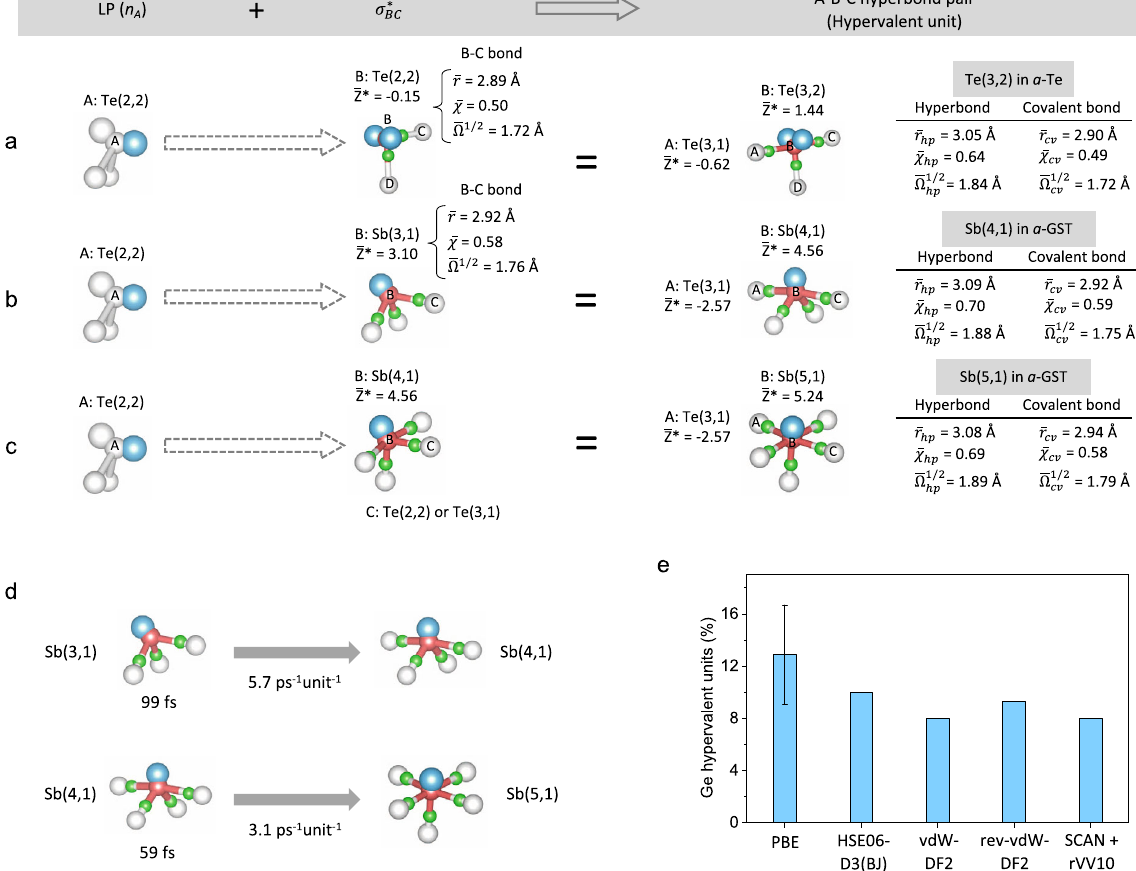
Fig. 4b, c, to the hypervalent units of Sb(4,1) and Sb(5,1) with a transition frequency of 5.7 and 3.1 ps − 1 unit − 1 , respectively (Fig. 4d). The formation of hypervalent Te(3,2) units in a -Te (Fig. 4a) is similarly directly observed from AIMD simulations at elevated temperatures.